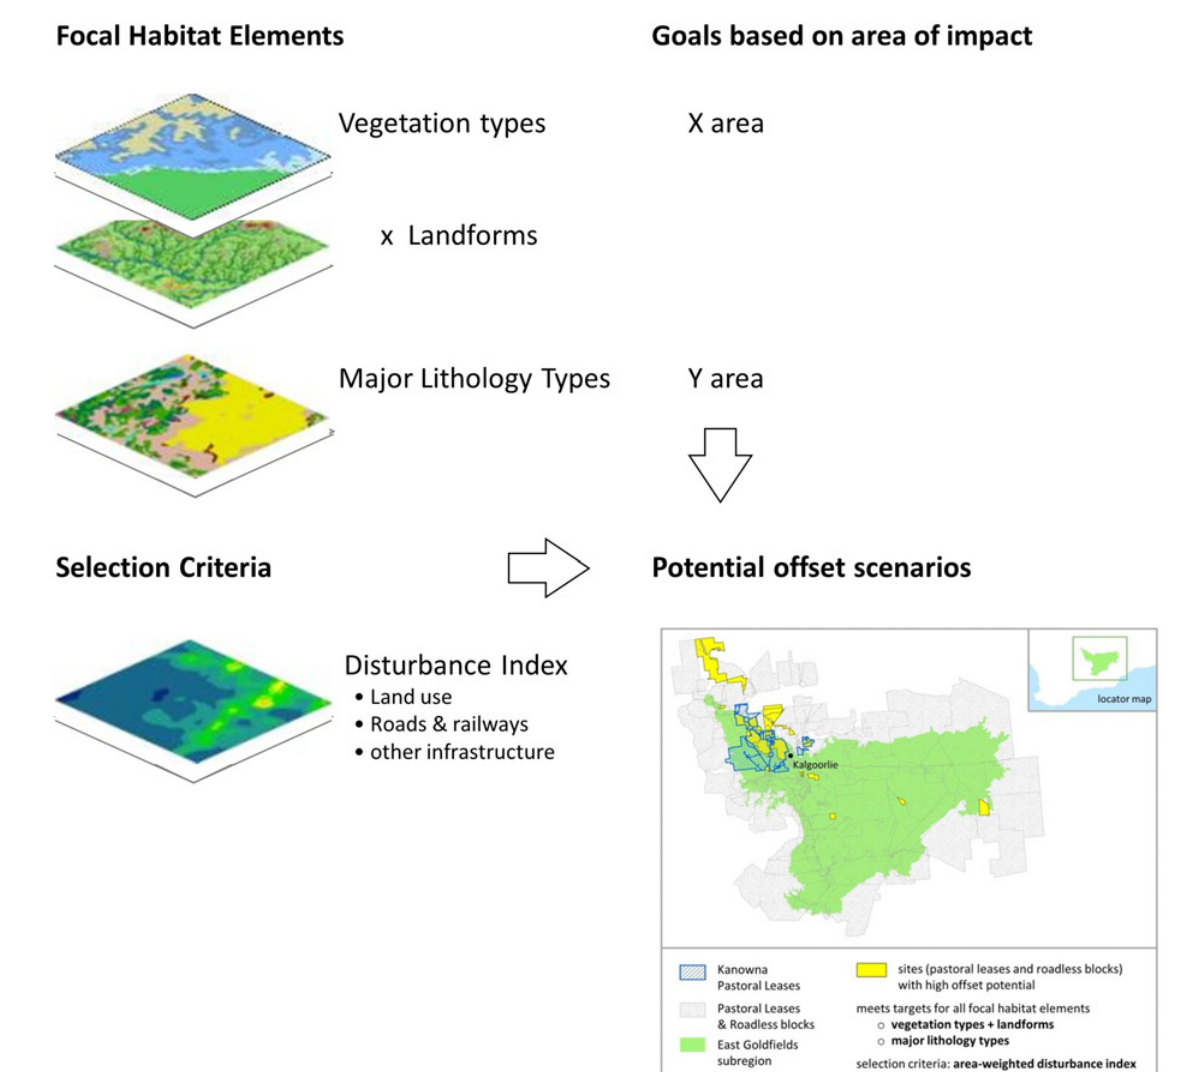
Figure 4. Identifying the Offset Portfolio. The flow chart illustrates the process and data sources for identifying a set of potential offset sites that contain similar habitat as the mining footprint and in configurations that contribute to conservation goals across the